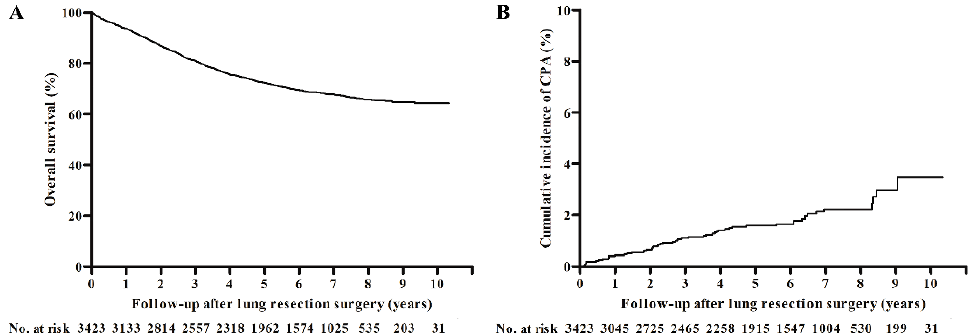
Figure 2. ( A ) Overall survival of the study population and ( B ) cumulative incidence of chronic pulmonary aspergillosis after lung cancer